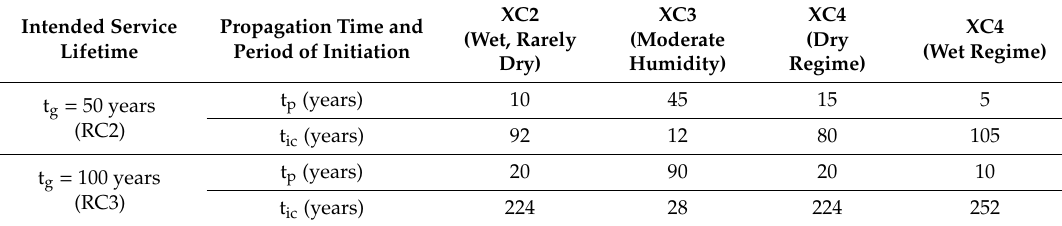
Table 5. Minimum propagation period and the initiation period due to carbonation.